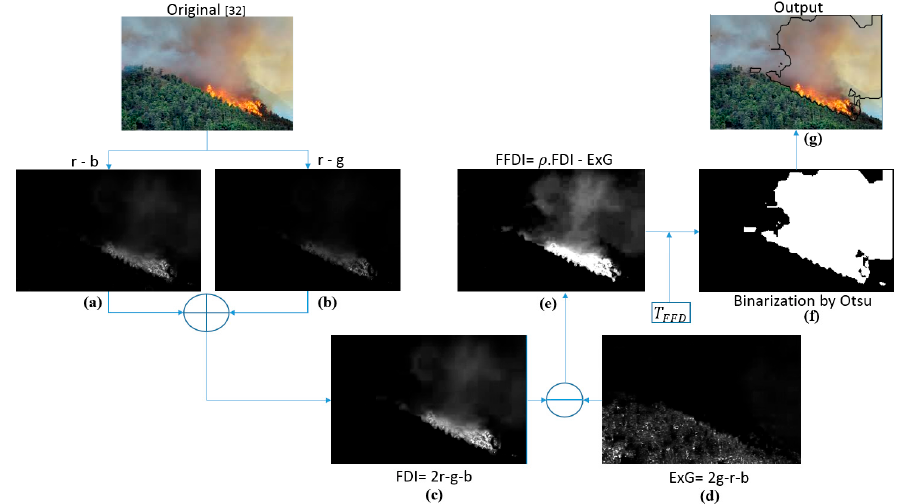
Figure 3. Diagram showing the forest fire detection process with color indices. Calculation of: ( a ) r minus b ; ( b ) r minus g ; ( c ) FDI (Fire Detection Index); ( d ) ExG (Excess Green colors) and ( e ) FFDI; ( f ) binarization; ( g ) detected fire region. The original image in this figure was taken from [32].